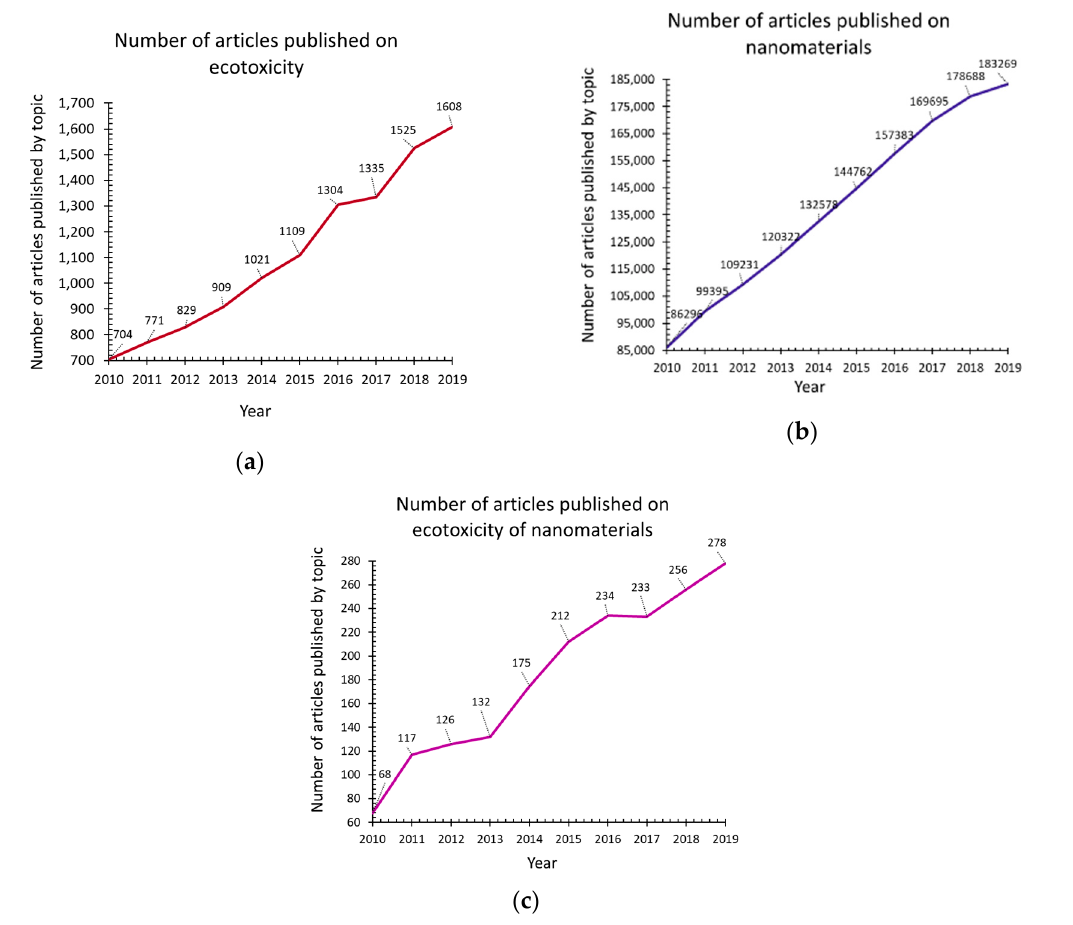
Figure 1. Bibliometric analysis of research in 2010–2019 from Web of Science Core Collection (Web of Science, Clarivate Analytics) on ( a ) ecotoxicity (search strategy: topic search (TS) = (Ecotox*) (containing “ecotox” in the topic of the articles)); ( b ) nanomaterials (search strategy: TS = (Nano*)) and ( c ) ecotoxicity of nanomaterials (search strategy: TS = (Ecotox* AND Nano*)).